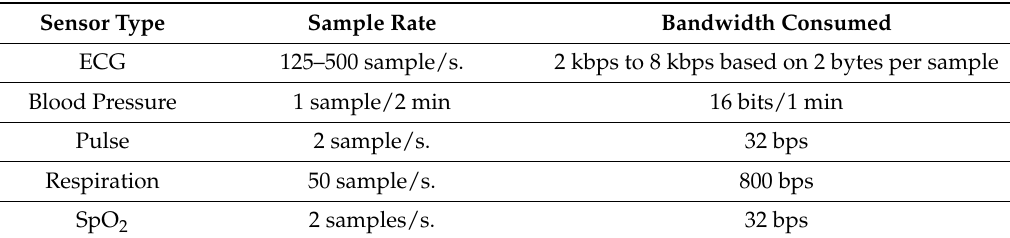
Table 2. Health Sensors and Bandwidth